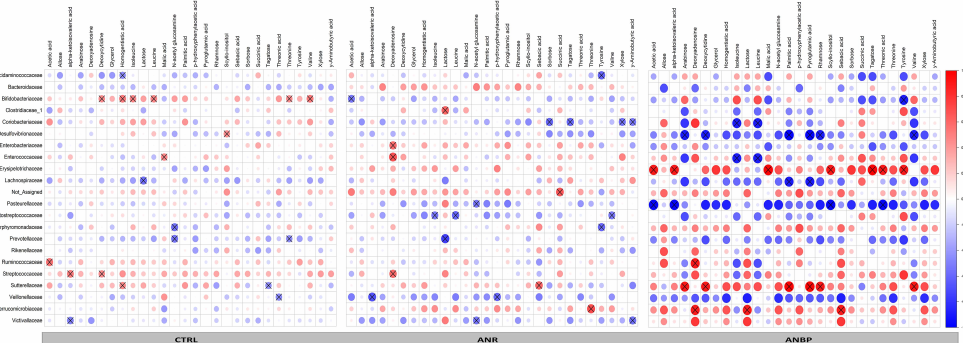
Figure 5. Heatmaps reporting the Spearman correlation coefficients (r) for each pairwise combination of microbial Family abundances and metabolite levels evaluated in patients with restricting anorexia nervosa (ANR), patients with binge-purging anorexia nervosa (ANBP), and healthy controls (CTRL). Crosses show the correlation coefficients with p <